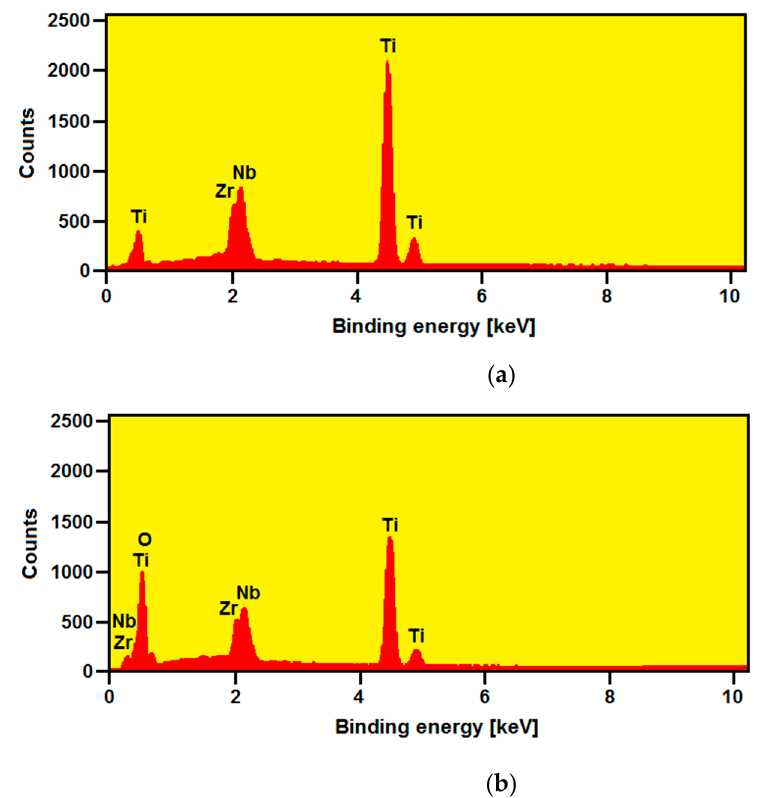
Figure 8. EDS spectrum for the Ti-13Zr-13Nb alloy surface: ( a ) Before anodizing; ( b ) After anodiz- ing at 35 V for 120 min. at 35 V for 120